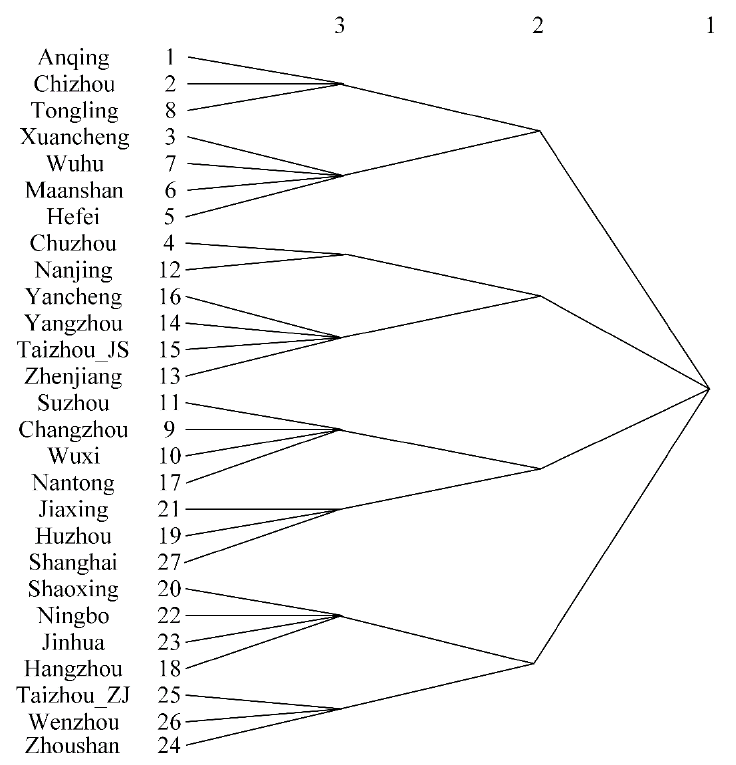
Figure 6. Division of cohesive